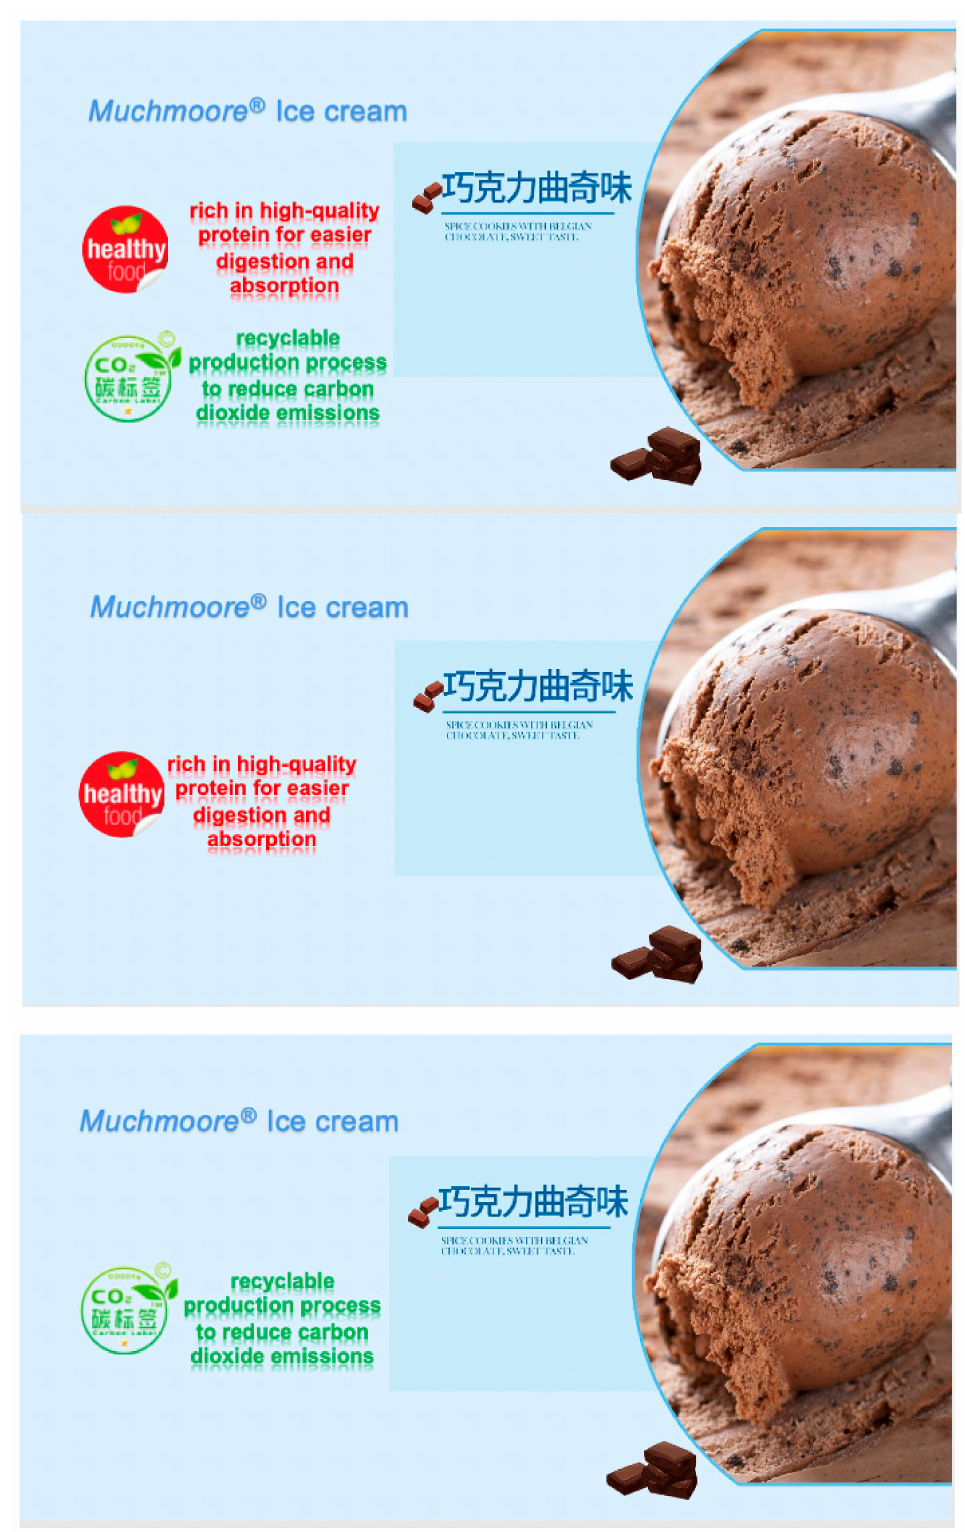
Figure 2. Labels in study